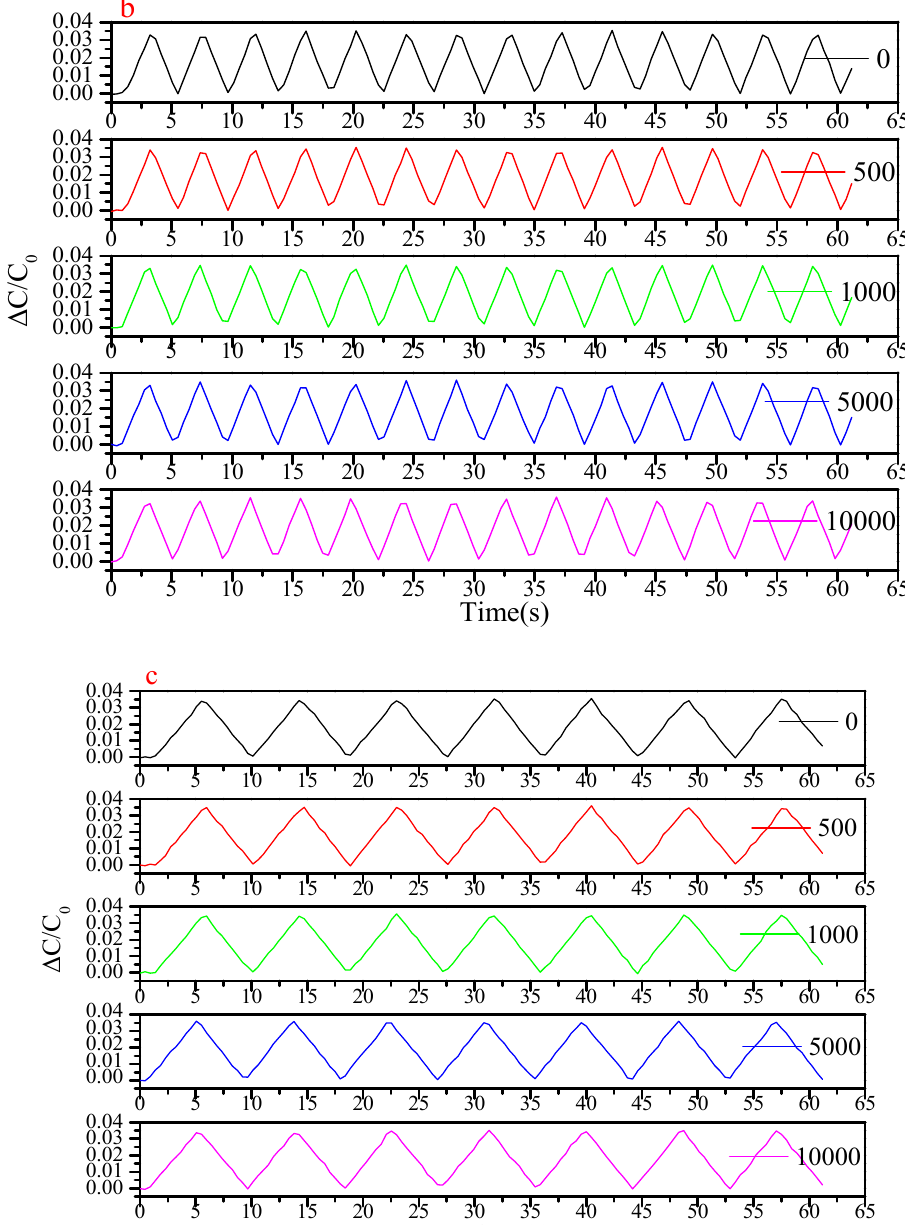
Figure A5. ( a ) Sensor record at the frequency of 0.5 Hz with 5% elongation at different times of the durability test; ( b ) at the frequency of 0.2 Hz with 5% elongation; ( c ) at the frequency of 0.1 Hz with 5% elongation.